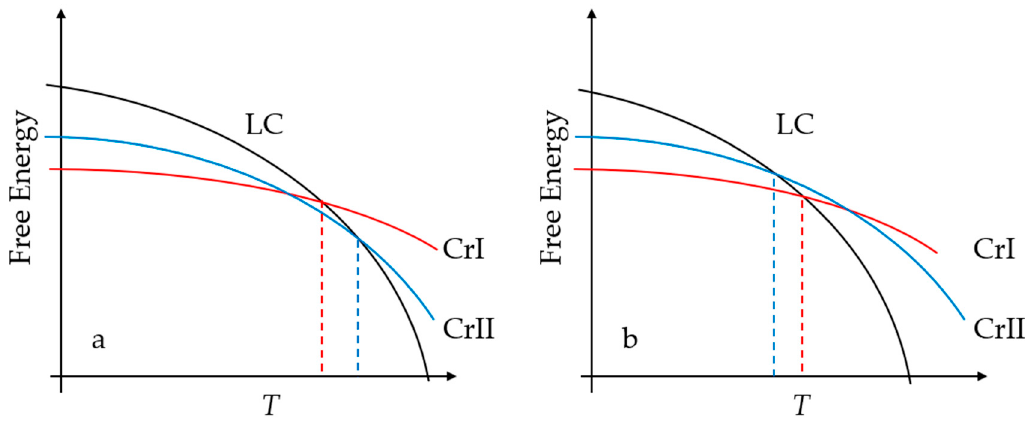
Figure 1. Schematics of ( a ) enantiotropic and ( b ) monotropic systems. CrI and CrII are two crystal polymorphs. We propose that the ionic liquid (IL) polymorphism in this work belongs to the former, but the transition from CrI to CrII did not occur during our molecular dynamics (MD)